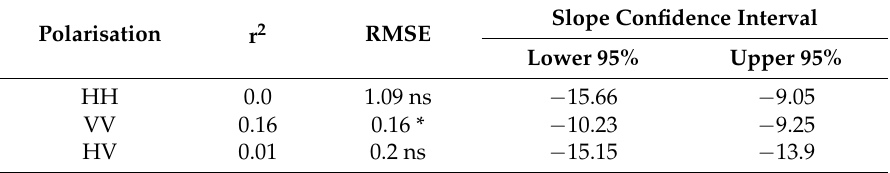
Table 8. Results from the regression models relating MIMICS-I simulated S-band backscatter ( σ ◦ ) to plot biomass for conifer stands in the Himalayas. r 2 is the coefficient of determination and RMSE is the root mean square error (t/ha) calculated using